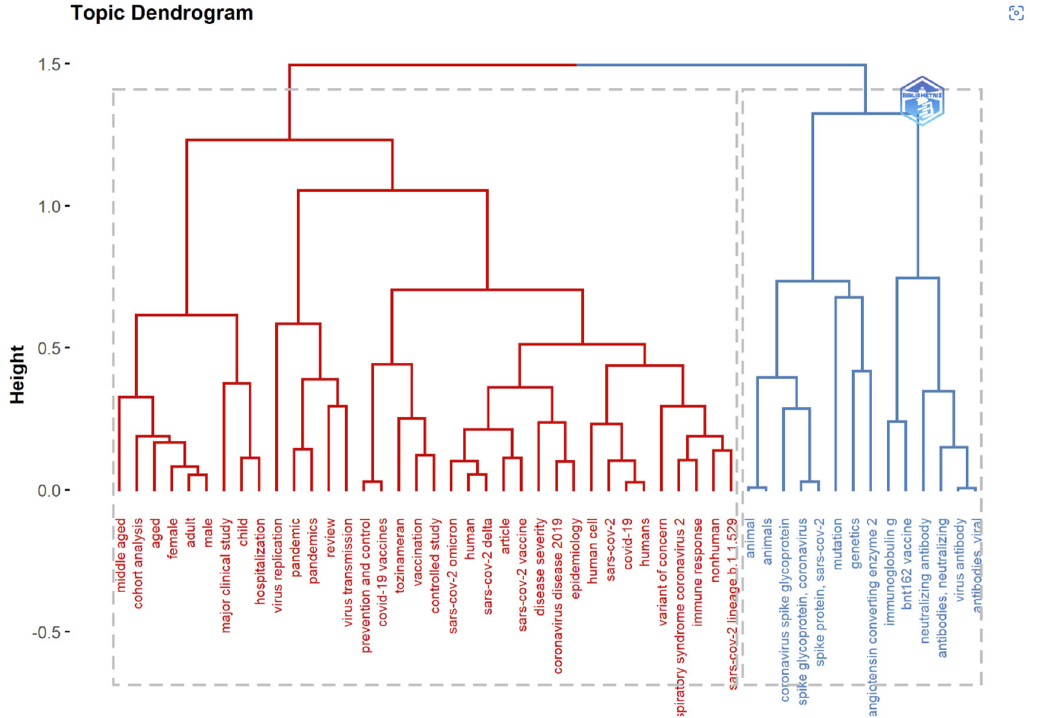
Figure 19. Topic dendrogram using correspondence analysis that shows the hierarchical relationship between the topics in the identified field.